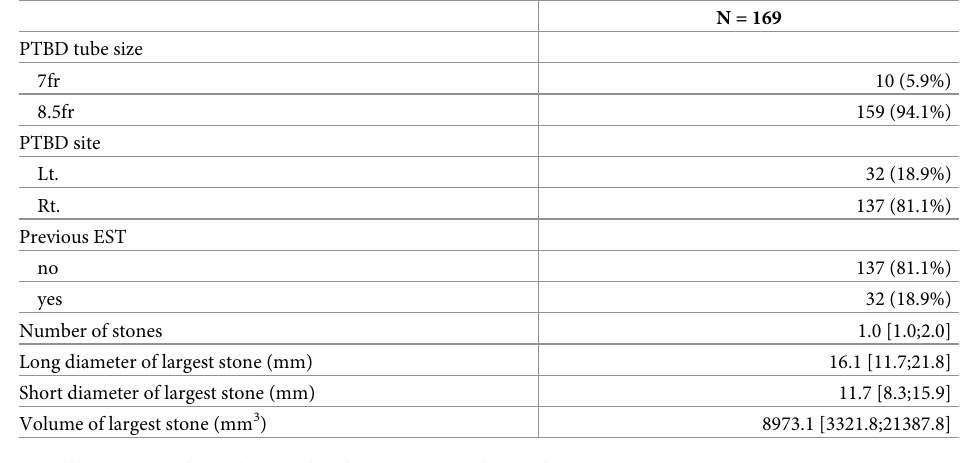
Table 1. The characteristics of the stone and procedure-related